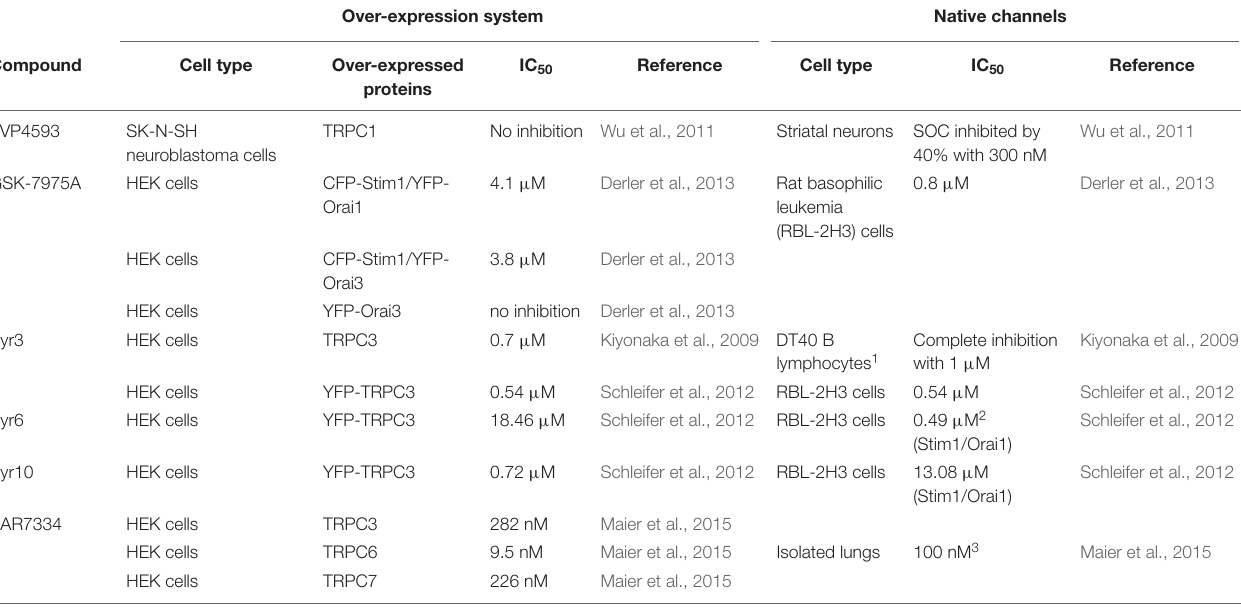
TABLE 2 | Alphabetical list of the Orai and TRPC channel blockers used in this study. Over-expression